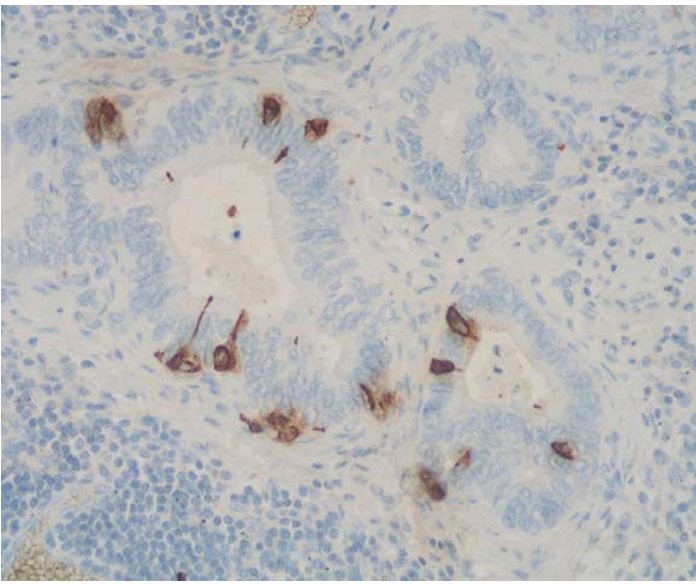
Figure 3. An adenocarcinoma showing scattered neuroendocrine cells, demonstrated using anti-chromogranin A antibody, cannot be classified as a